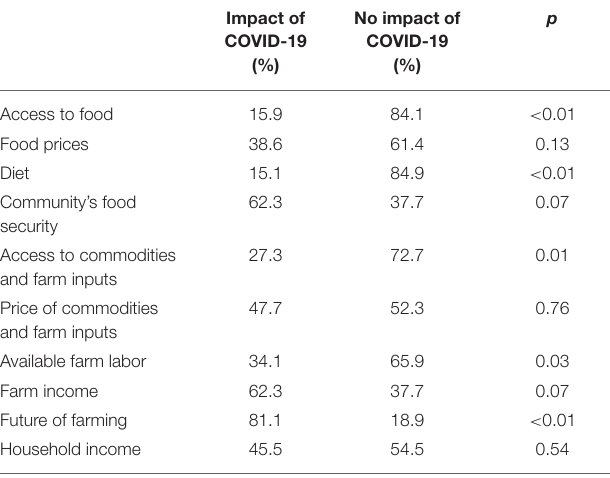
TABLE 7 | Perceived effects of COVID-19 on farm economy, food security, and